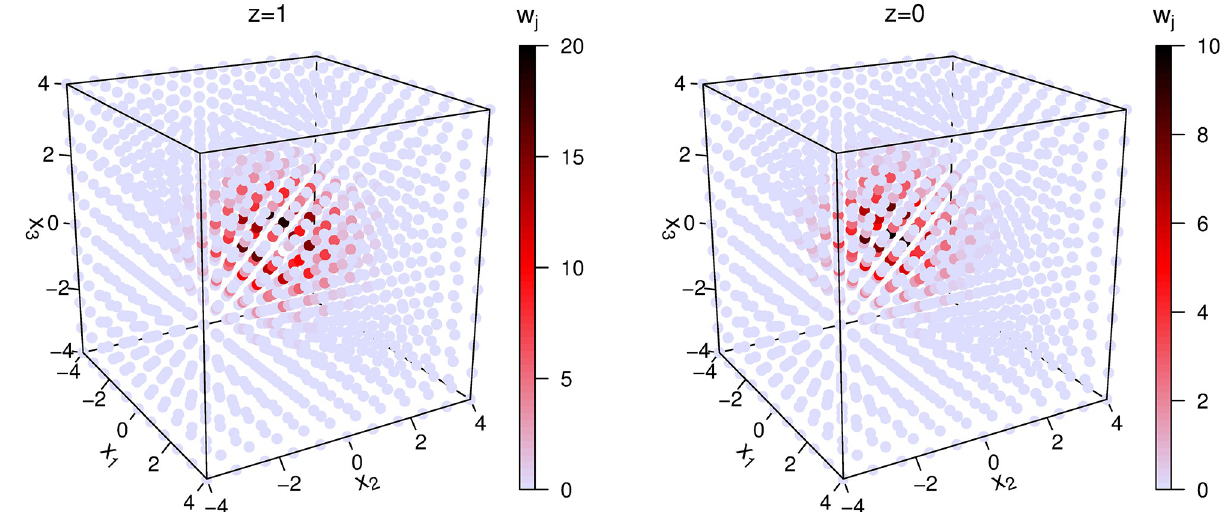
Fig 2. Scatter plots of the grid points with the weights w j under z = 1 (left column) and z = 0 (right